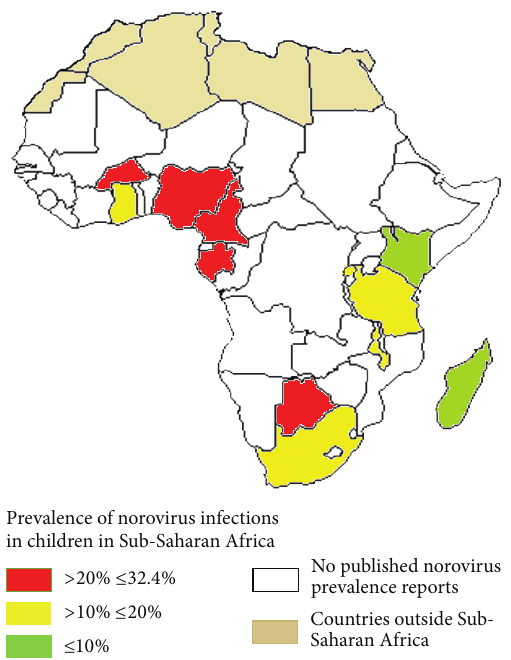
Figure 1: Countries where norovirus infections in children have beenreportedinSub-SaharanAfrica.Countrieswithhighnorovirus prevalence( > 20% ≤ 32.4%)arerepresentedbytheredcolour.Yellow: countries with norovirus prevalence between 10% and 20%. Light green: countries with less than 10% norovirus prevalence. At the time of writing this review, there were no published reports about prevalence rates of norovirus infections in children in other Sub- Saharan African countries apart from the ones represented by red, yellow, and light green